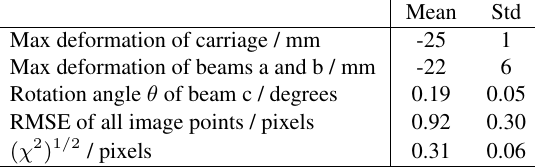
Table 1: Mean and standard deviation of deformation results of all 15 combinations of one to four